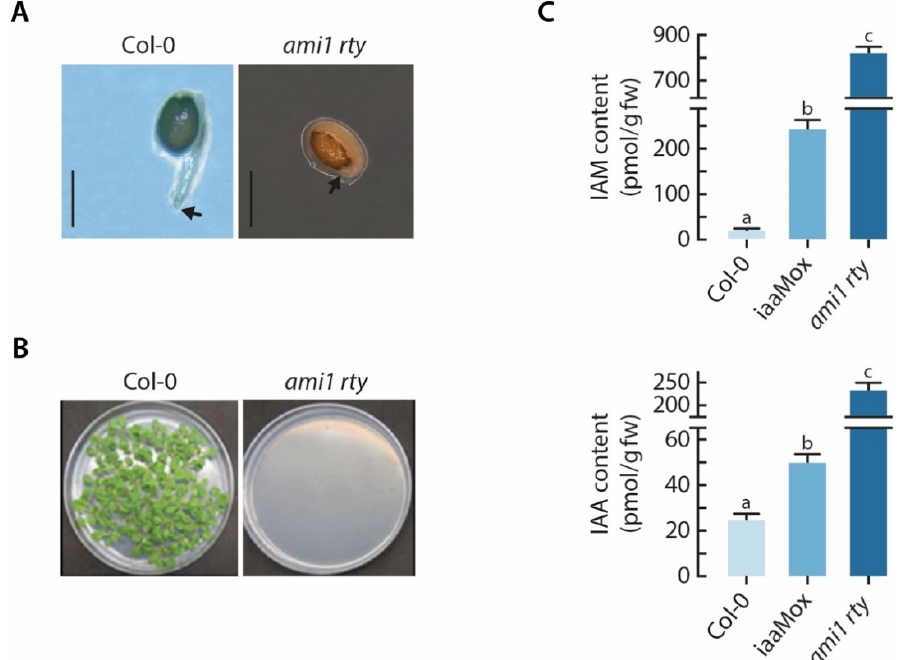
Figure 3. Seeds of ami1 rty mutants show a severe growth arrest and accumulation of IAM and IAA. ( A ) The photographs show close-ups of wild type (wt) (Col-0) and ami1 rty seeds grown on ½ Murashige & Skoog plates. The arrows mark the tip of the primary root two days after emergence. At this stage, the ami1/rty root stops growing. Scale bars = 1 mm. ( B ) The figure shows the comparison of wt (Col-0) and ami1 rty mutant seeds grown on ½ MS plates. The ami1/rty seeds abort germination, while wt (Col-0) seeds were able to germinate. ( C ) Analysis of IAM and IAA levels in wild-type Arabidopsis, iaaMox, and ami1 rty . Imbibed seeds from wild-type Arabidopsis (Col-0), iaaMox, and the ami1 rty double mutant were analyzed for their endogenous IAM (upper panel) and IAA levels (lower panel). The plots show mean values with their corresponding standard errors (SE), n = 5. To assess significant differences between the endogenous levels of each compound an analysis of variance ( ANOVA ) of the scores followed by Tukey’s post-hoc test was performed. The different letters indicate significant differences, p ≤ 0.001.